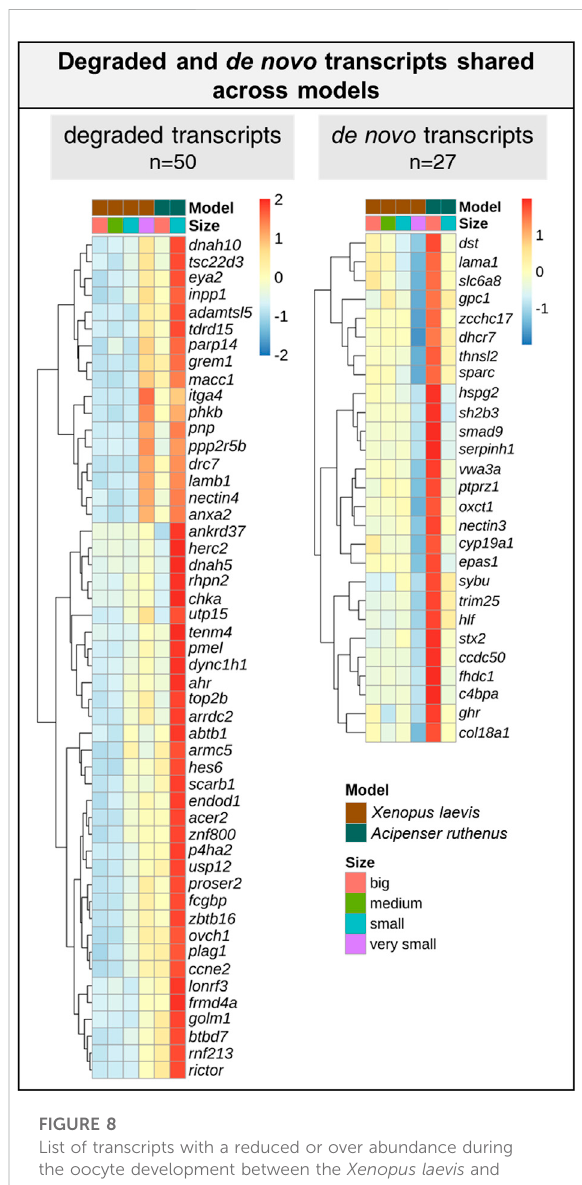
FIGURE 8 List of transcripts with a reduced or over abundance during the oocyte development between the Xenopus laevis and Acipenser ruthenus . Heatmap is based on the Z-score of the percentage mean transcript expression relative to each model. Representative transcripts show a minimum of ~1.5x change relative to a given oocyte